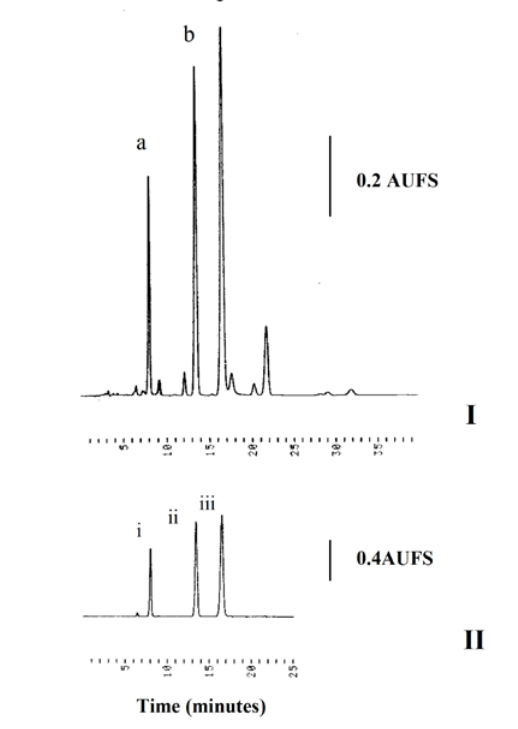
Figure 6. I) HPLC chromatogram of active sub-fraction CF2. Peaks: (a) TMF, (b) sinensetin, (c) eupatorin; II) HPLC chromatogram of standards. Peaks: (i) TMF, (ii) sinensetin, (iii)